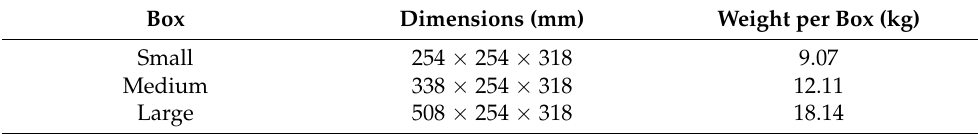
Table 8. Weight and dimensions of boxes used for model